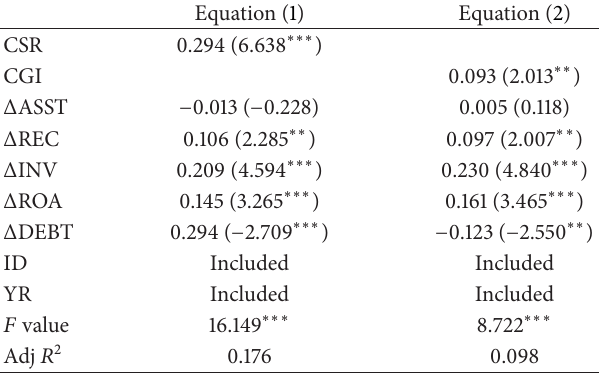
Table 7: Results of regression analysis with